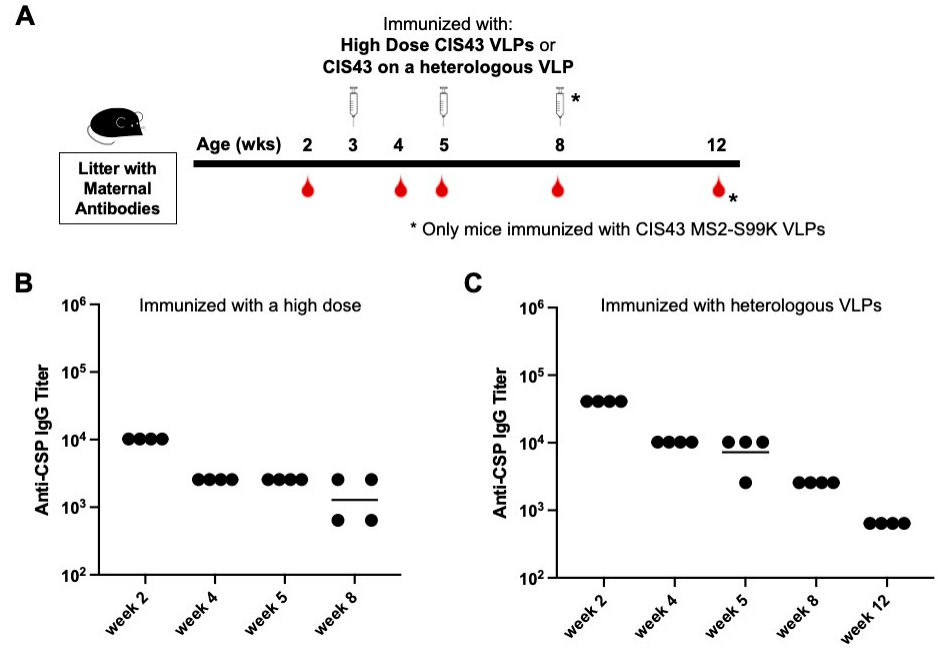
Figure 3. Pups with maternal antibodies do not respond to immunization with high-dose vaccine or CIS43 displayed on a heterologous VLP platform. ( A ) Experimental set-up – pups from CIS43 VLP-immunized dams were immunized with either ( B ) 20 µ g of CIS43 VLPs, or ( C ) 5 µ g of CIS43 MS2-S99K VLPs at the indicated ages. In both experiments, sera were collected at the indicated ages and anti-CSP IgG endpoint titers were measured by ELISA. Each data point represents an individual mouse and lines denote the geometric mean titer of each group.